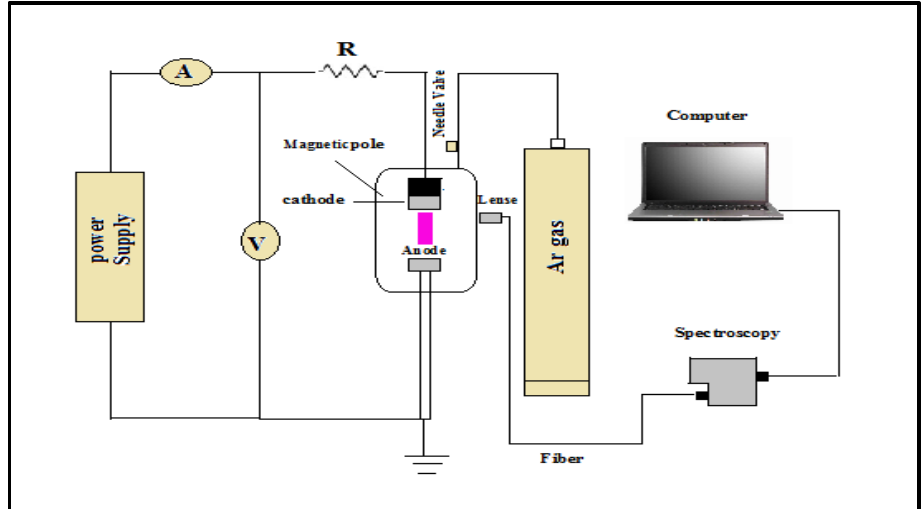
Fig.1: Experimental setup of magnetron sputtering system.